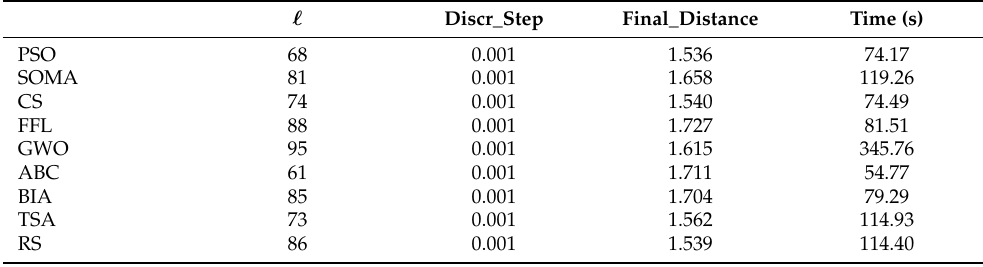
Table 11. The mean results for Function f 3 for 50 runs of evolutionary algorithms with a value of maxFES =